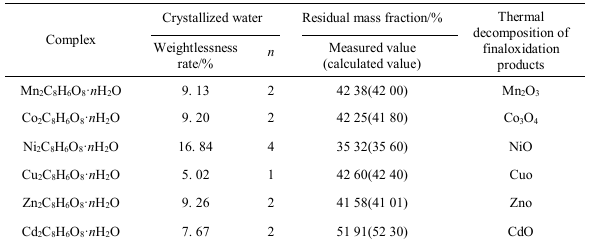
Table 1. Thermogravimetric data of complex in dynamic air